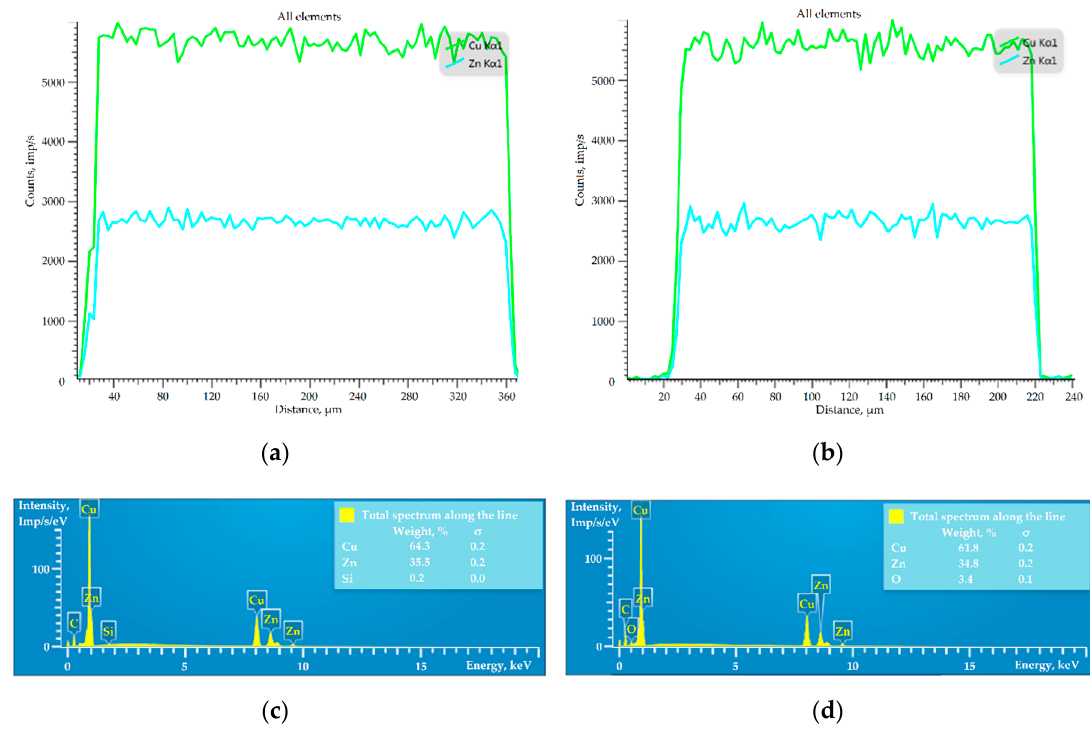
Figure 12. Chemical analyses of the worn tool electrode cross-section after machining: ( a ) chemical elements along the line at front wear; ( b ) chemical elements along the line at lateral wear; ( c ) EDX spectrum at front wear; ( d ) EDX spectrum at lateral wear.